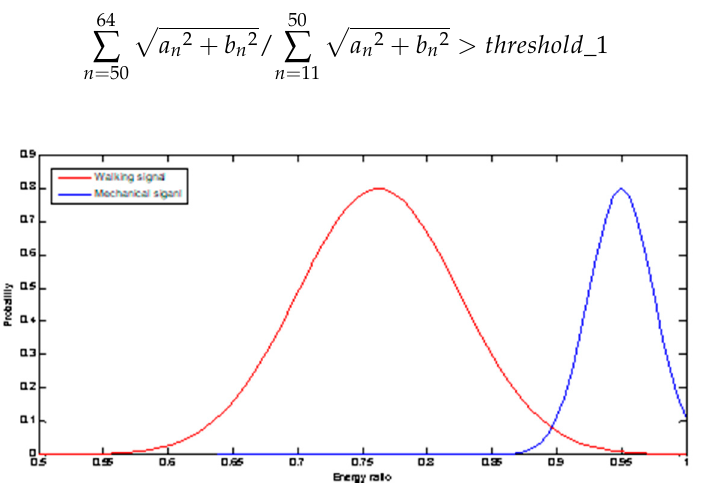
Figure 6. The selection processing of thresholds.